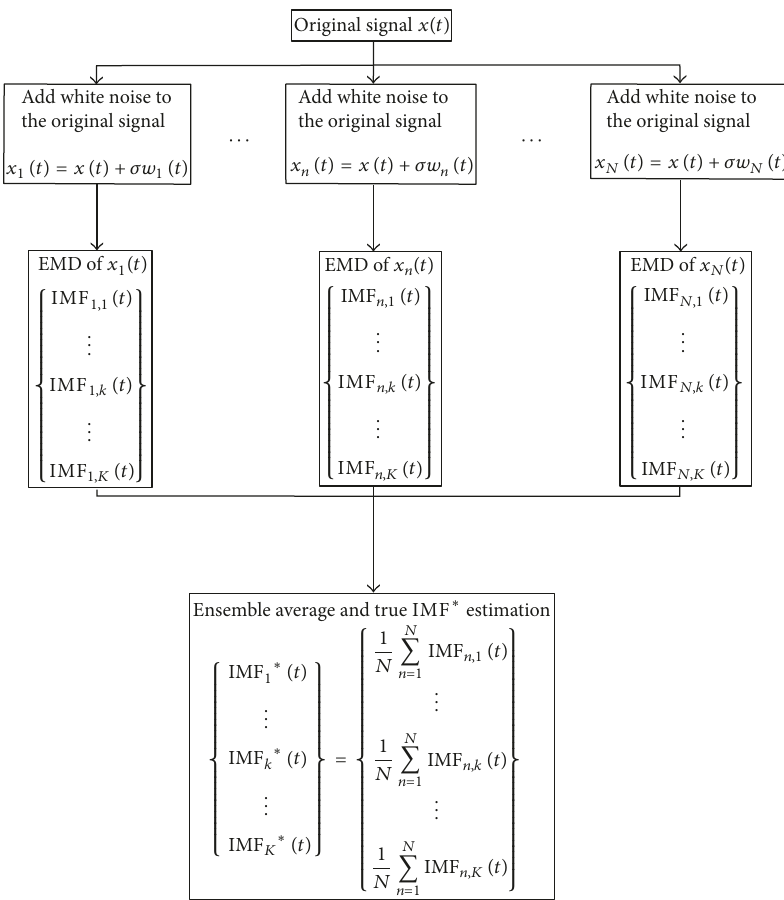
Figure 2: Flow-chart of the EEMD algorithm with 𝑁 trials and 𝐾 modes per